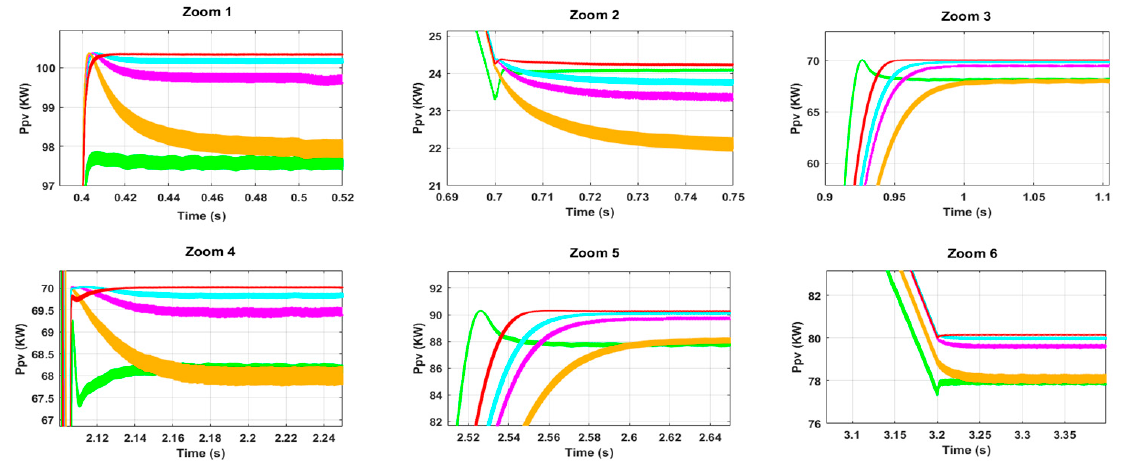
Figure 6. Zoomed parts of the PV output power waveform.